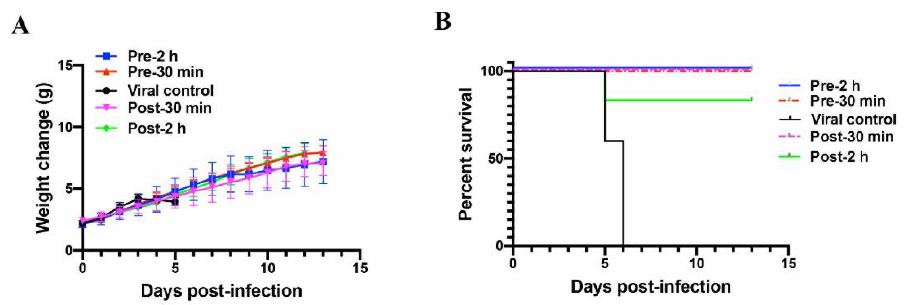
Figure 6. In vivo HCoV-OC43 inhibitory activity of EK1P4HC. ( A ) Bodyweight change of HCoV- OC43-infected newborn mice. ( B ) Survival curves of HCoV-OC43-infected newborn mice.